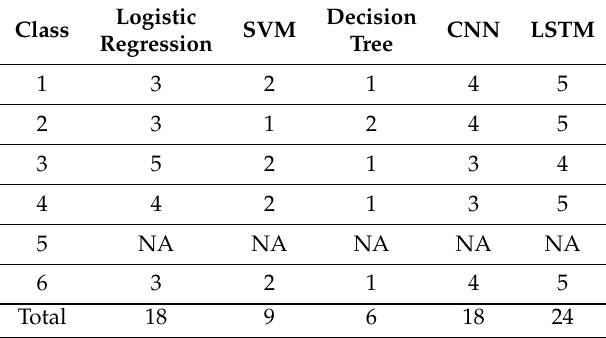
Table 13. Classifier performance